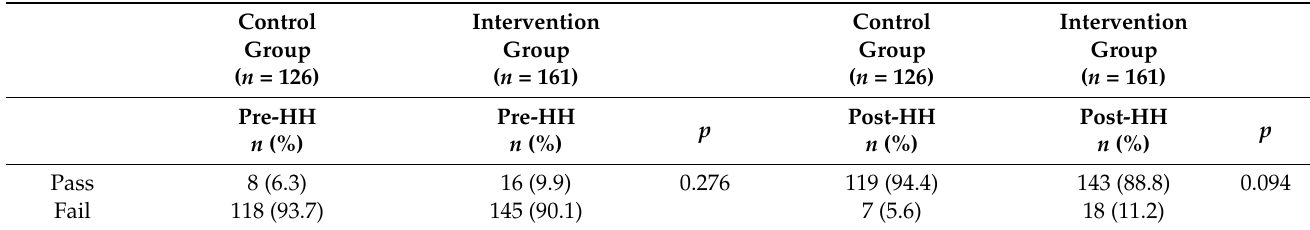
Table 3. Intervention data (HH). Independent sample results.